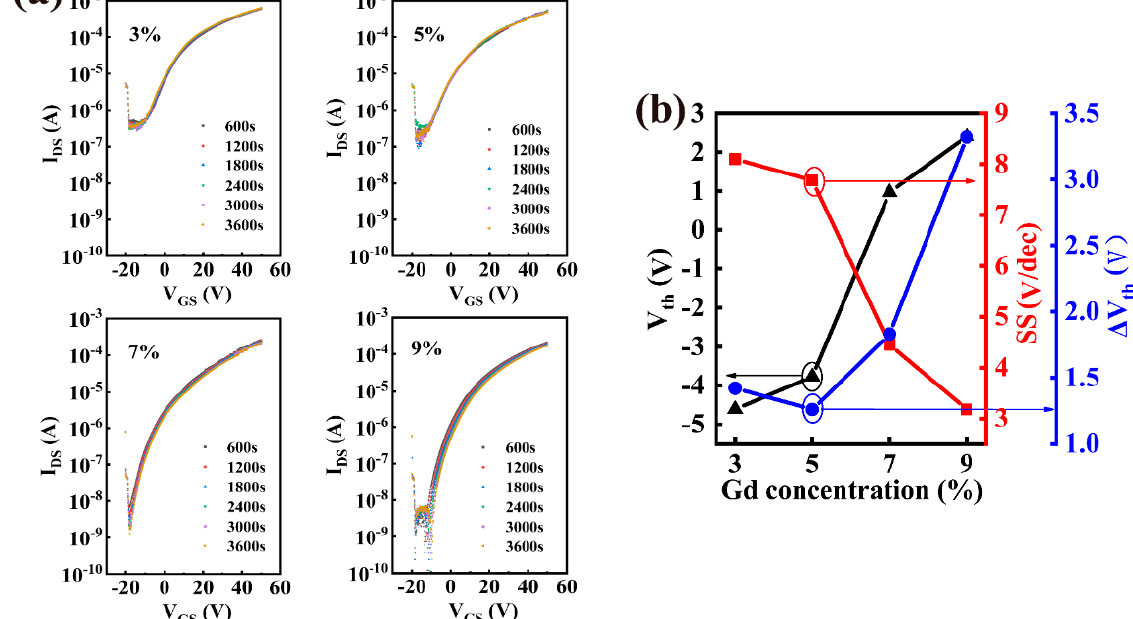
Figure 4. ( a ) The evolution of the transfer cures as a function of applied stress time at V DS = 10 V of the In 2 O 3 /InGdO TFTs with different Gd concentrations. ( b ) The volatility of threshold voltage, subthreshold swing and ∆ V th of the In 2 O 3 /InGdO TFTs with increasing Gd concentrations. Table 1. Extracted electrical parameters in the In 2 O 3 /InGdO TFTs with various Gd doping concentrations.